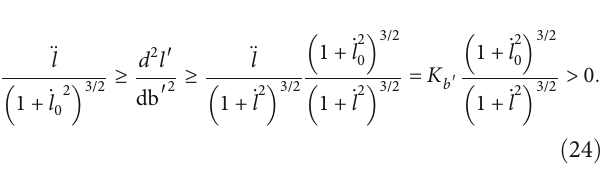
in the weaving maneuver mode. a